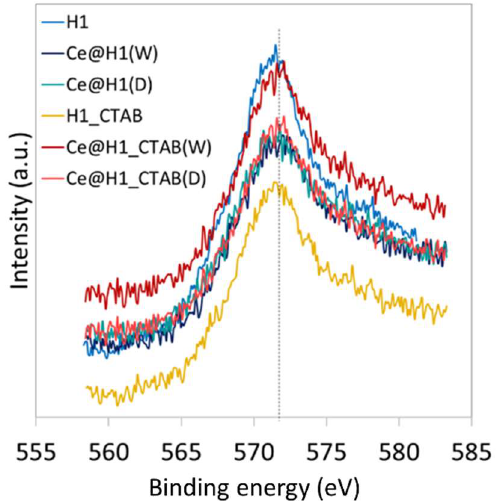
at 1440 cm −1 can be ascribed to C=O of uncoordinated H 3 BTC [40]. In addition, on the FTIR spectra of H1_CTAB and Ce@H1_CTAB(D) there are low intensity bands at 2853 and 2923 cm −1 (Figure 9a) that correspond to the symmetric and asymmetric stretching modes of CH 2 coming from trapped CTA + Figure 8. CuLMM Auger spectra for HKUST-1 and Ce@HKUST-1 materials. Figure 8. CuLMM Auger spectra for HKUST-1 and Ce@HKUST-1 materials.